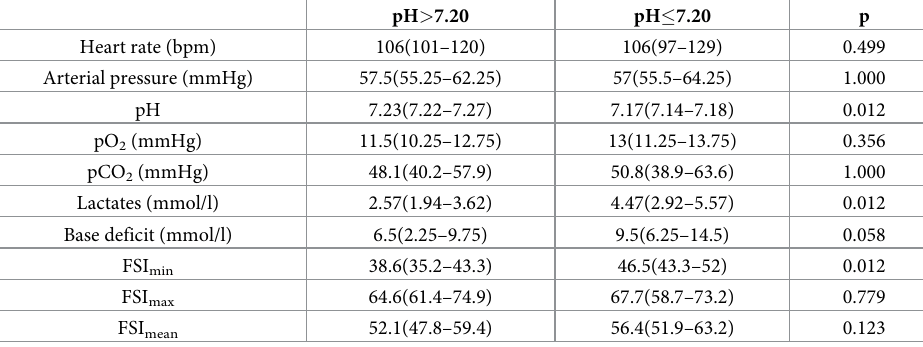
Table 2. FSI variation according to pH ranges during occlusion.